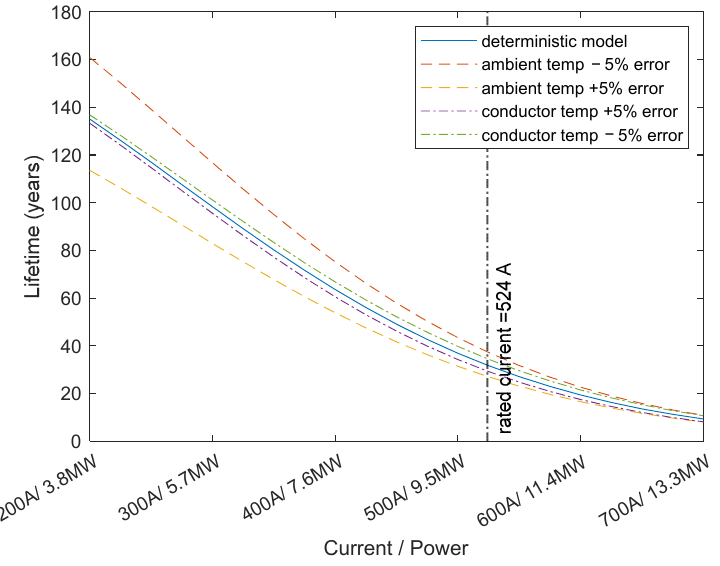
Figure 5. The lifetime curve for applied current and loading for the 11 kV XLPE cable.